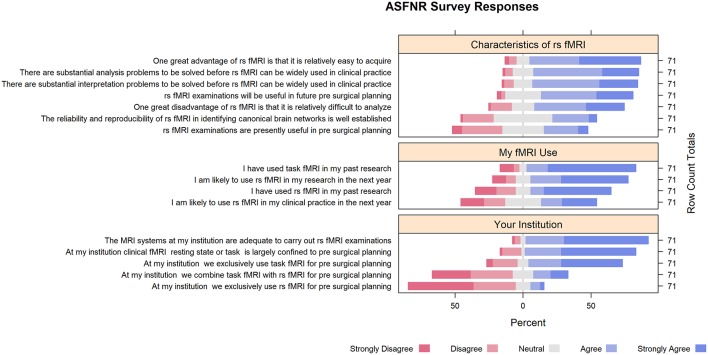
Survey responses.